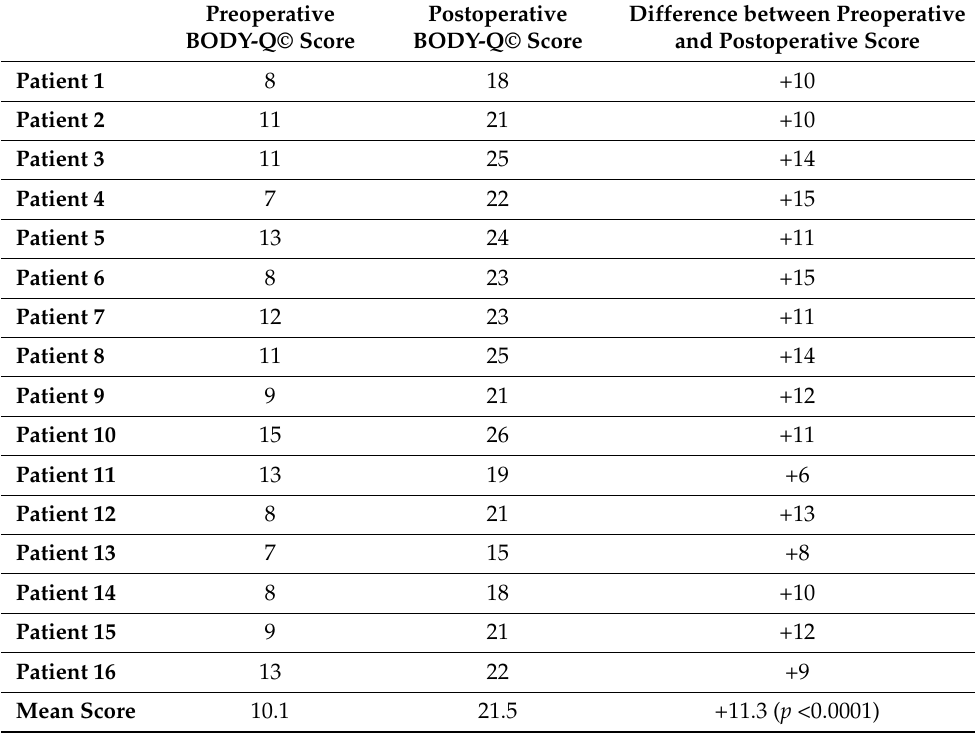
Table 3. Difference between the sum of the preoperative and postoperative BODY-Q©